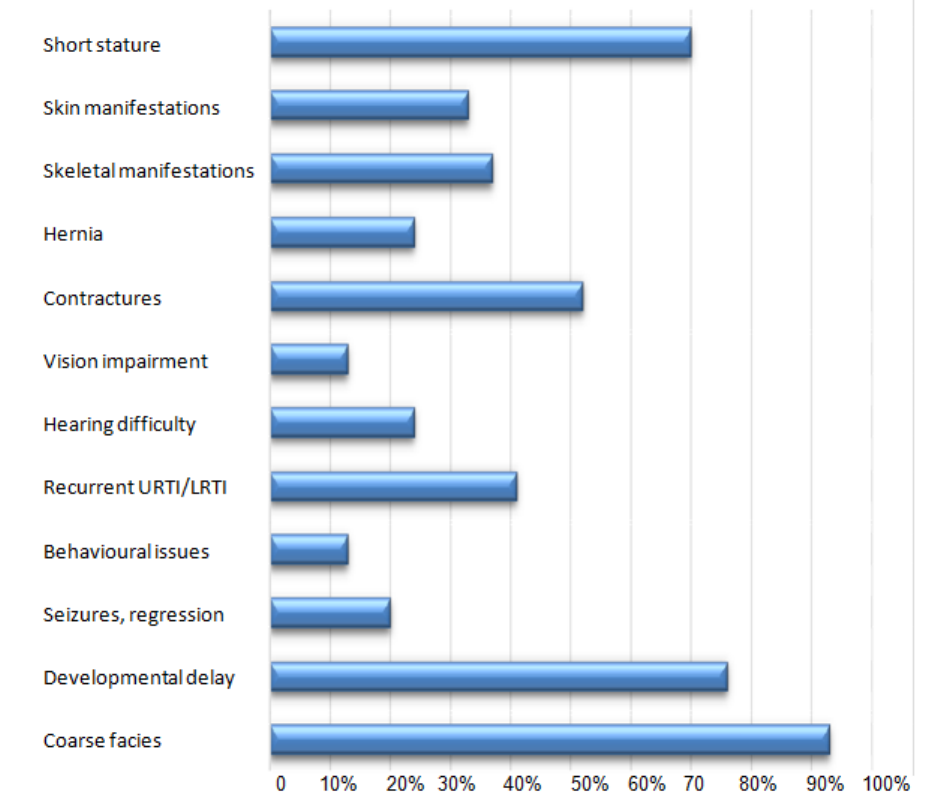
Figure 2. Clinical symptoms in various types of MPS in present study.